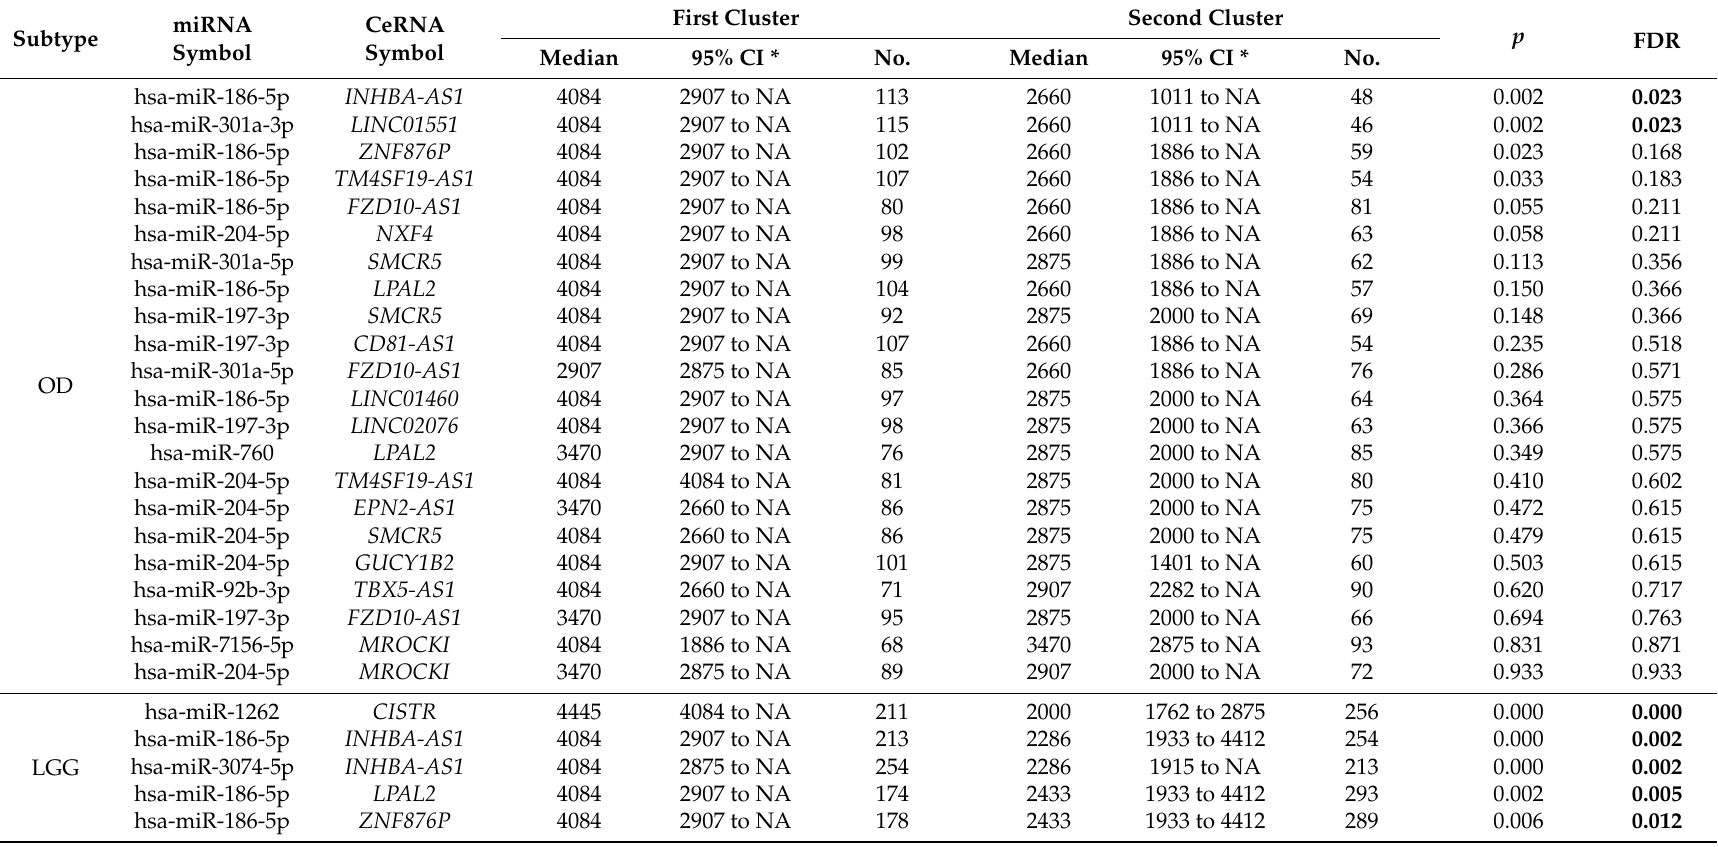
Table 2. Kaplan–Meier survival analysis with miRNA and ceRNA having negative correlation coe ffi cients of less than −